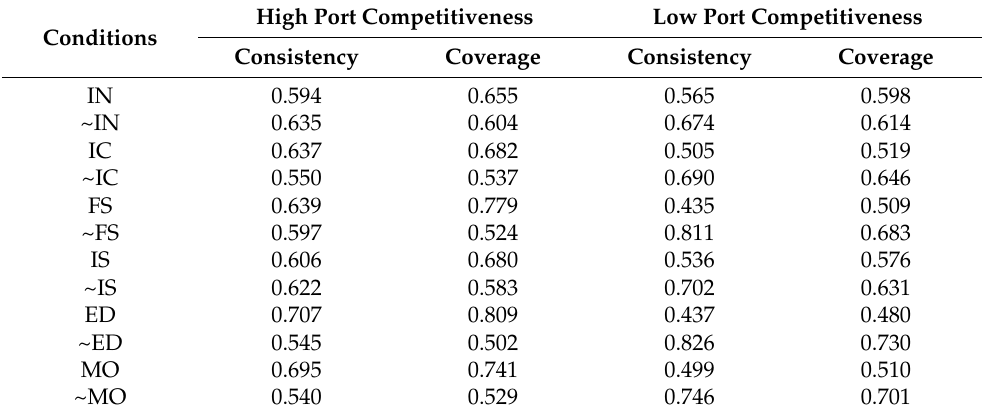
Table 5. Results of necessary condition